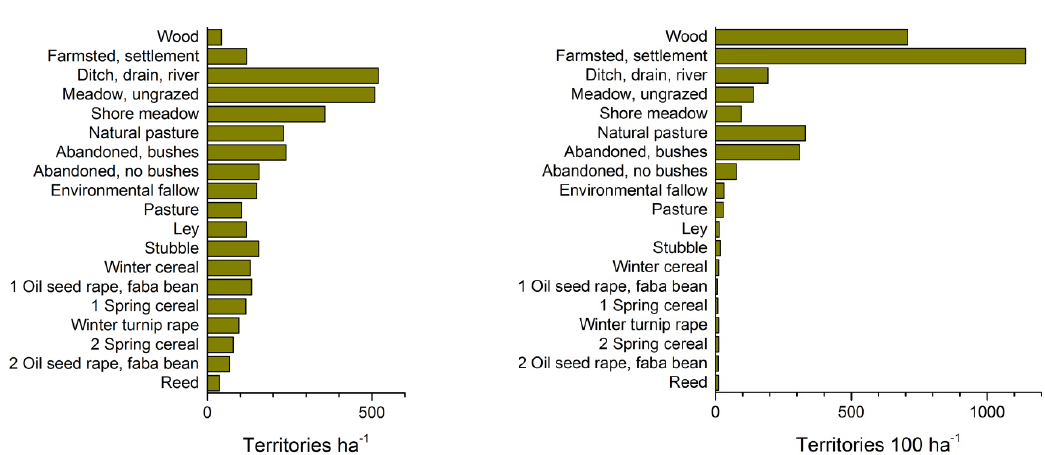
Fig. 3. Breeding density of farmland birds of open habitat (left) and farmsteads, settlements and forest edge (right) in 2009– 2011 (based on 26815 bird territories and censuses on 9926 ha of farmland; number of species 16 and 20, respectively) (redrawn from Tiainen and Seimola 2014). 1 and 2 for spring cereal and oil seed rape and field bean refers to direct sowing and sowing with tillage,